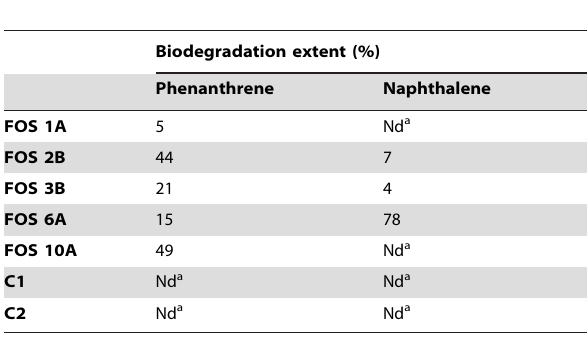
Table 1. Hydrocarbon biodegradation by the metagenomic fosmid